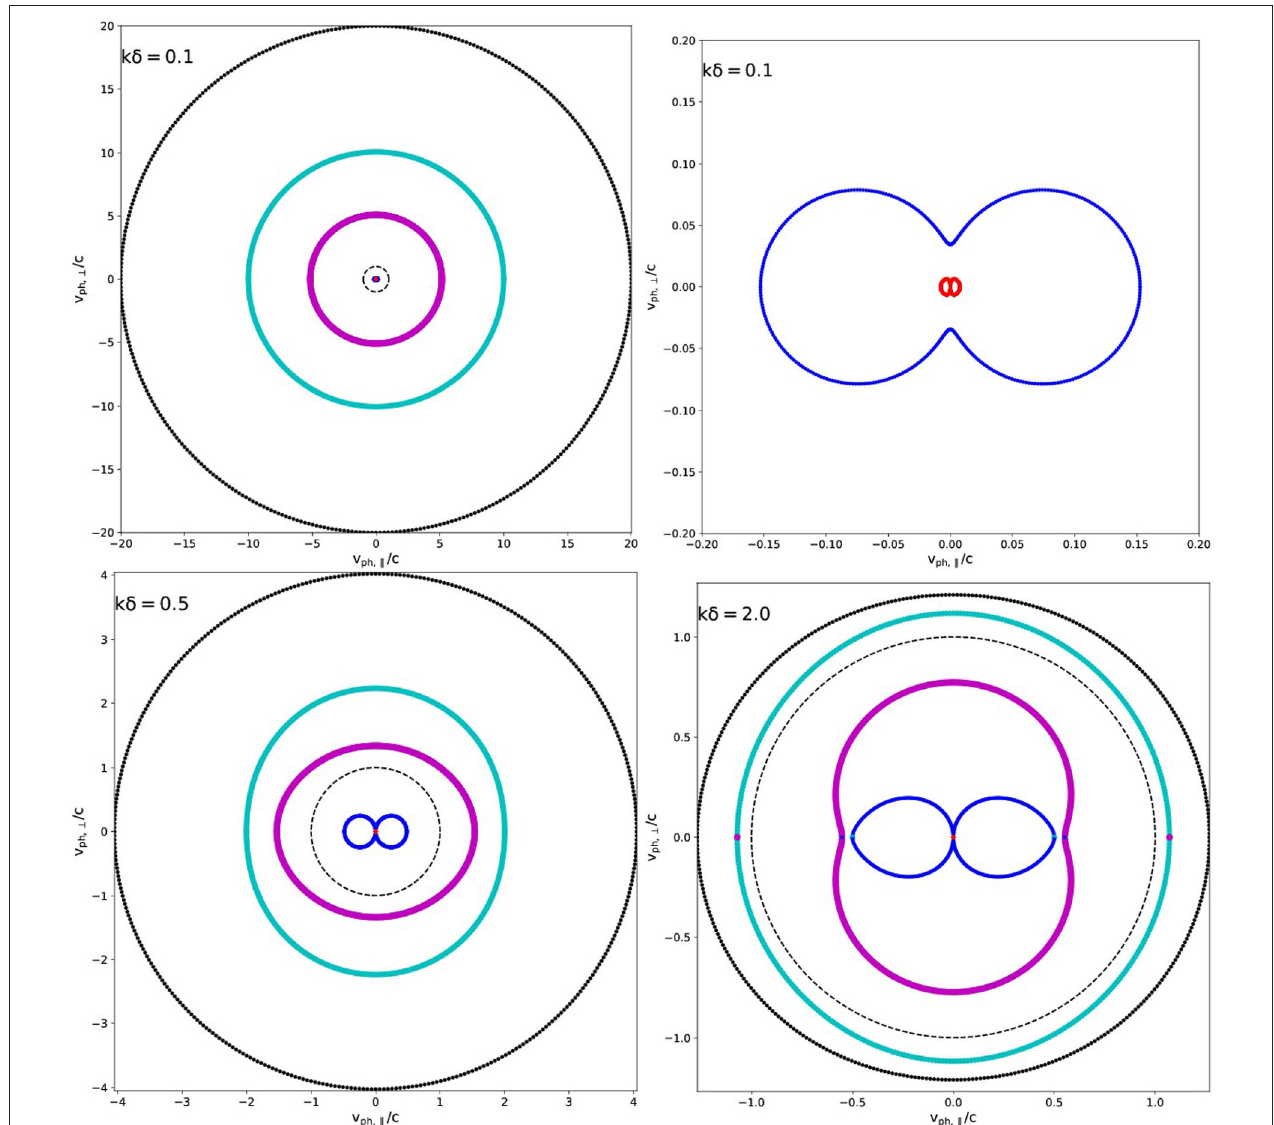
FIGURE 5 | Selected 5-mode phase diagrams at three different values of k indicates the light circle, hence notice the varying scale. This is for a hydrogen plasma with E electromagnetic modes are black ( ω X ) and cyan ( ω O ), followed by purple ( ω M or Middle), blue ( ω F or Fast) and red ( ω A or Alfvén) wave. Note that in the k right) plot, at parallel orientation (horizontal central line), mode exchanges occurred between the cyan, purple and blue branches. We always show all 5 branches, such that the red Alfvén branch requires further zooming in to see its details: this is done in the top right panel for the k